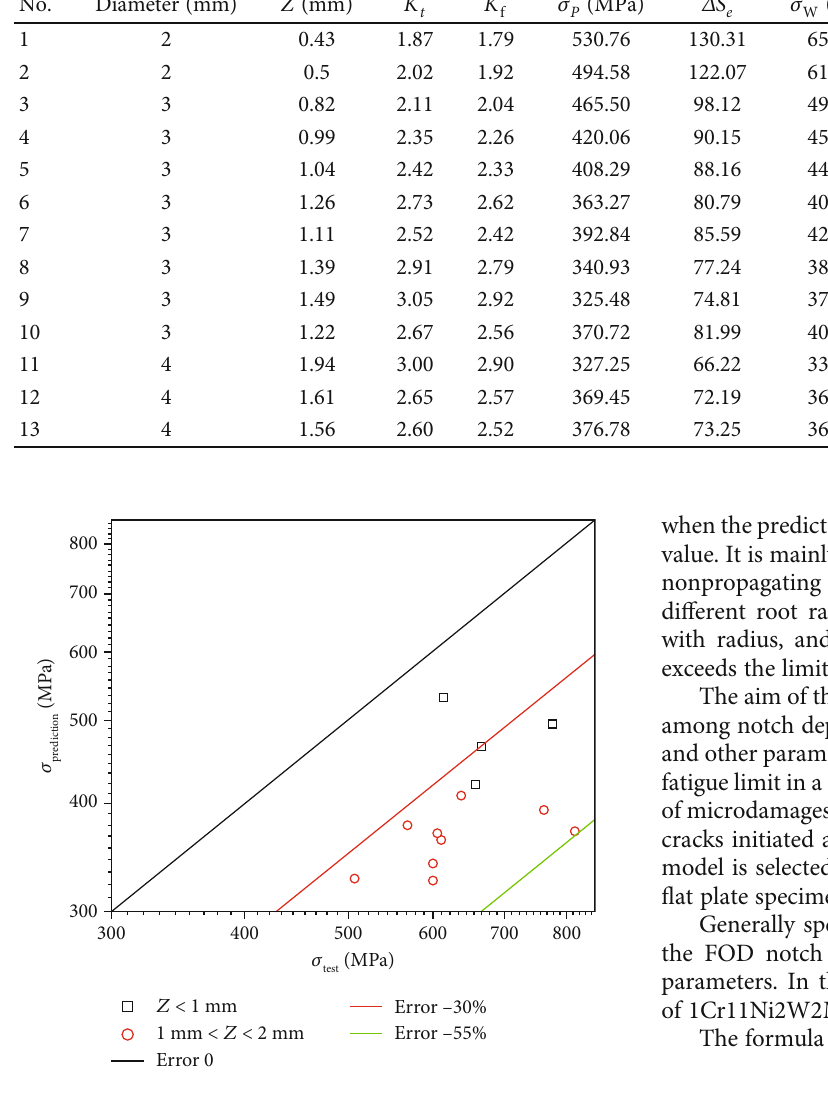
Figure 14: Prediction error distribution of Peterson